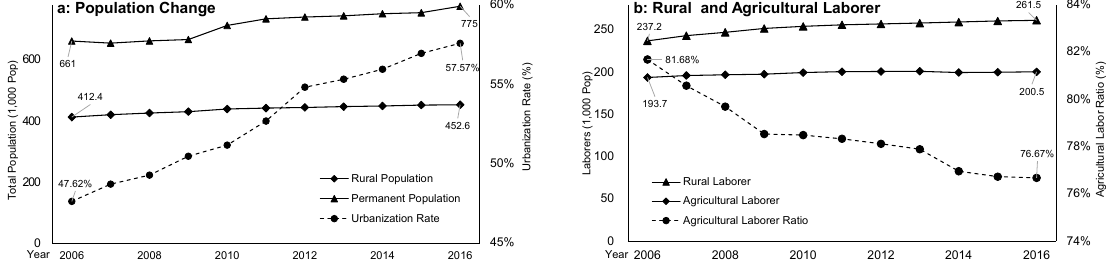
Figure 5. Population ( a ) and labor ( b ) changes in Xichang from 2006–16.